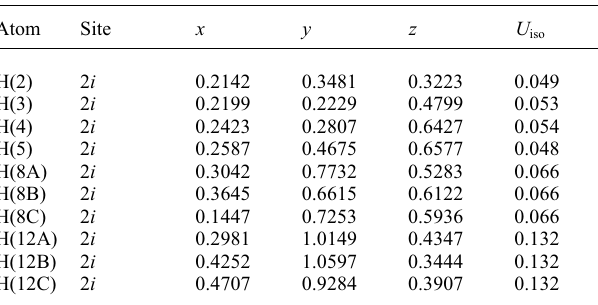
Table 2. Atomic coordinates and displacement parameters (in Å 2 )